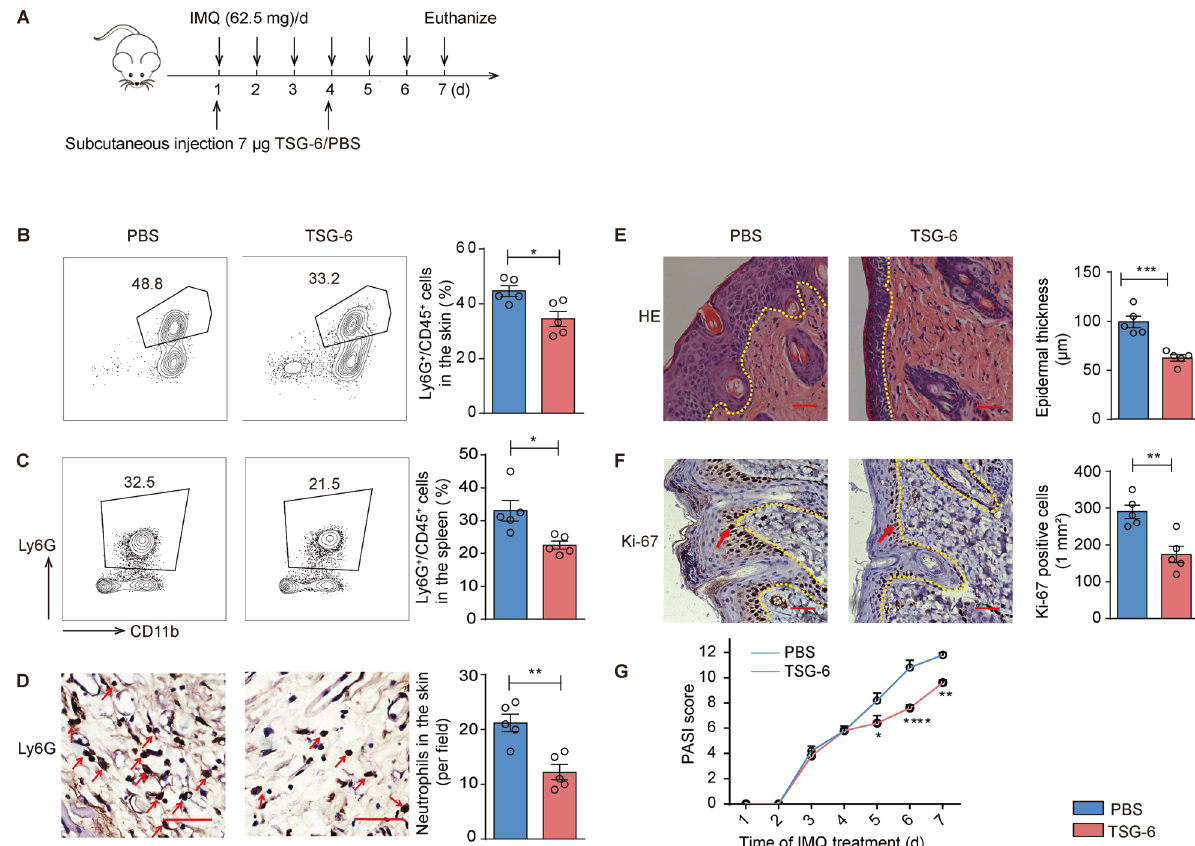
Fig. 5 Exogenous TSG-6 ameliorated murine psoriasis-like in fl ammation. The psoriatic mice were injected subcutaneously with 7 µg rhTSG- 6 dissolved with 150 µL PBS or 150 µL PBS alone on days 1 and 4 ( n = 5 mice for each group). A The experimental scheme. B , C rhTSG-6 impaired neutrophil accumulation in spleen and skin of IMQ-induced psoriatic mice; enumeration of neutrophil frequency in skin and spleen. D The Ly6G immunostaining of skin in both groups; enumeration of Ly6G positive cells. E H&E staining of lesions; measurement of